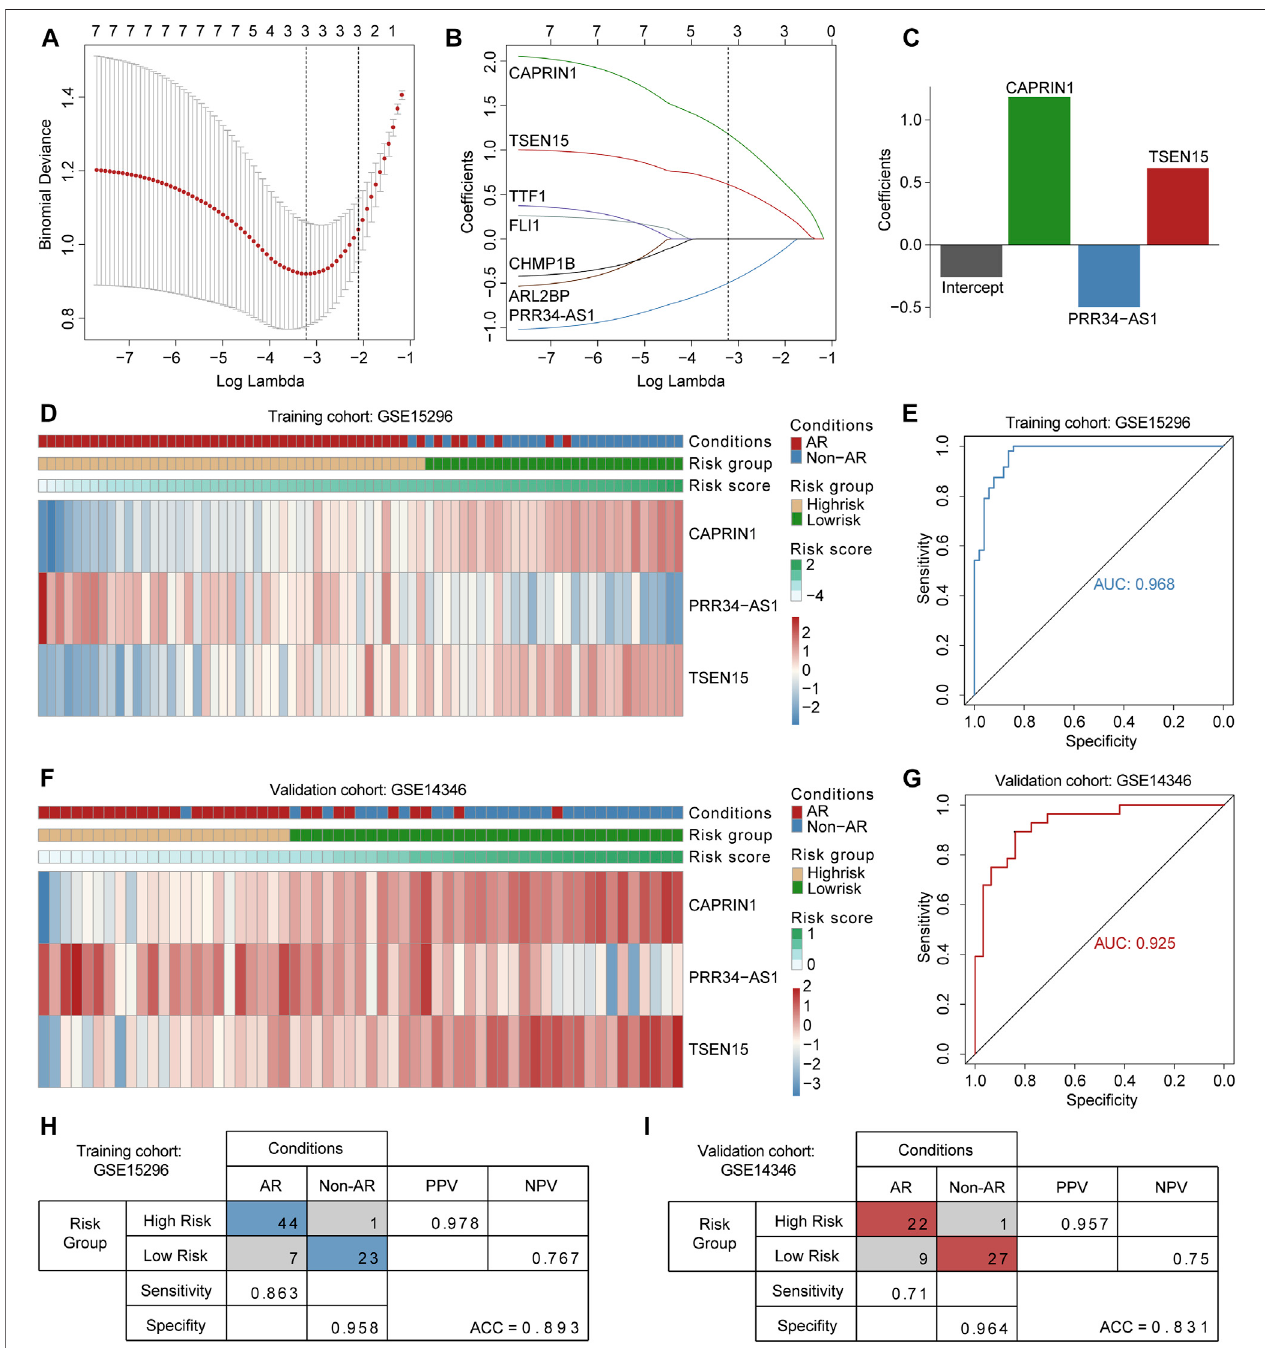
FIGURE4| Constructionandvalidationofthethreegene-baseddiagnosticmodel (A) SelectionofthetuningparameterinLASSOlogisticregressionanalysis.Ten- fold cross-validation was utilized to calculate optimal lambda which leads to minimum mean cross-validation error (B) LASSO coef fi cient pro fi les, where each curve represents a DEG. Three DEGs were fi nally selected under the optimal lambda to construct a diagnostic model (C) The bar plot shows coef fi cients of three genes in the diagnostic model (D and F) Heatmaps for expression levels of three genes in the training and validation cohorts, patient annotations including disease status and risk score are also depicted (E and G) ROC curves for ARdiagnosis prediction in the training and validation cohorts (Hand I) Confusion matricesof binary results of the diagnosticmodelfortrainingandvalidation cohorts.ROCcurves:receiveroperatingcharacteristiccurves.PPV:positivepredictivevalue.NPV:negativepredictivevalue.